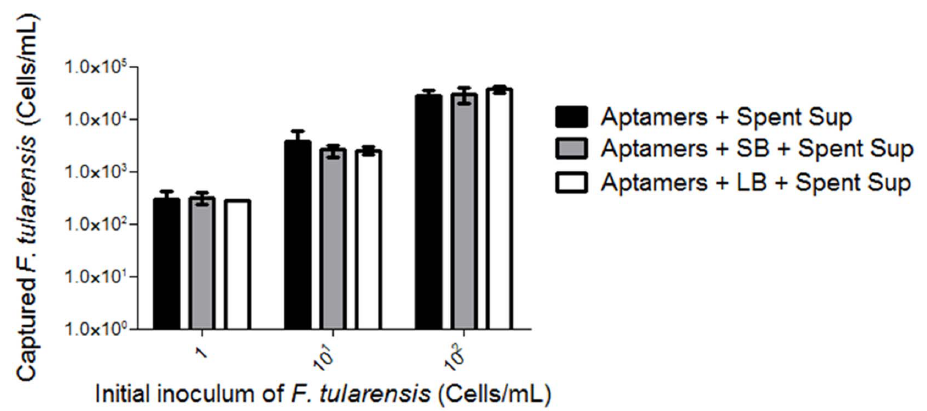
Fig. 4. Combined enrichment with spent culture supernatant and DNA aptamer capture leads to complete isolation of F. tularensis . F. tularensis (1–10 2 cells/mL) mixed samples in soil and/or lettuce homogenates were enriched for by overnight incubation with 10% spent culture supernatant and F. tularensis cells were subsequently captured by the DNA aptamer pool. Samples were denatured and the supernatant was subjected to real-time PCR analysis. Aptamers combined with either soil or lettuce bacteria alone (controls) showed Cp values greater than 34 and were considered negative for F. tularensis . Legend: Aptamers and Spent Sup (Spent supernatant) 5 black bar, Aptamers and SB and Spent Sup 5 grey bar, and Aptamers and LB and Spent Sup 5 white bar.